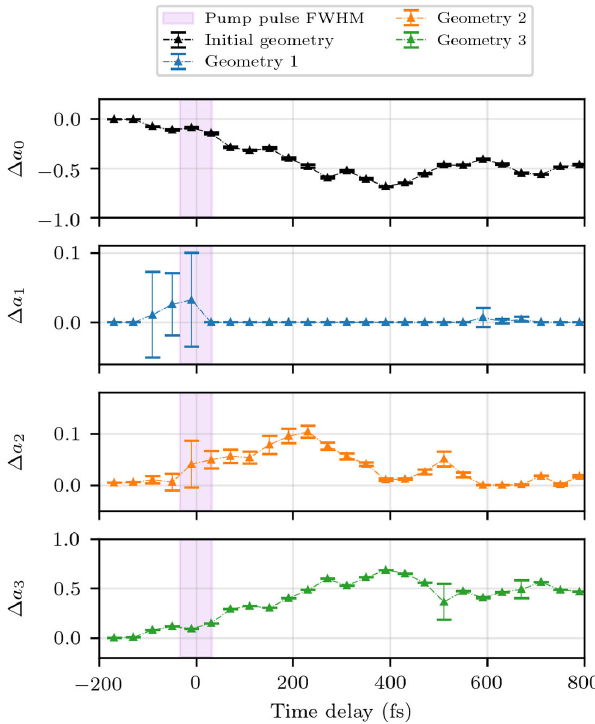
FIG. 5. Contributions of the different configurations of the target to the total absorption. The purple shaded area illustrates the duration (FWHM) of the pump pulse. The amplitudes Δ a i are the results of fitting Eq. (2) to the experimental data. The error bars depict the fit error. Here, Δ a 0 shows the temporal evolution of the cationic initial geometry, with the nuclei being at their respective positions in the neutral molecule, and Δ a 1 , Δ a 2 , and Δ a 3 represent the absorption contributions from the cationic geometries as drawn in Fig.